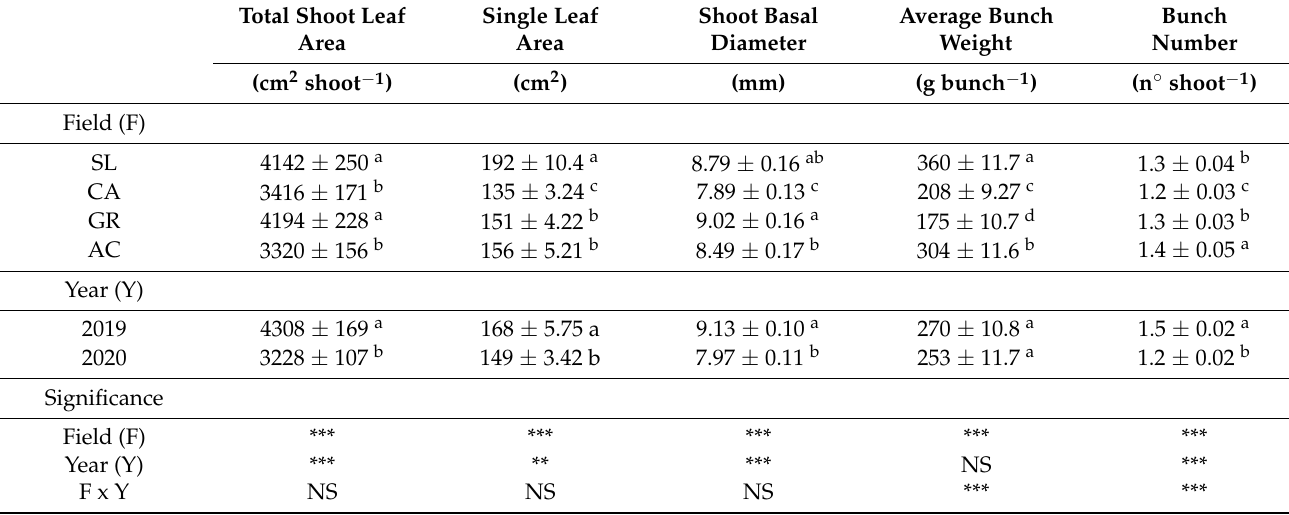
Table 1. Effects of field (F), year (Y), and their interaction (F x Y) on total shoot leaf area, single leaf area, shoot diameter, bunch weight, and bunch number per shoot of V. vinifera subsp. vinifera ‘Falanghina’ vines at the four study sites: SL-Santa Lucia, CA-Calvese, GR-Grottole, AC-Acquafredde. Mean values and standard errors are shown. Total Shoot Leaf Single Leaf Shoot Basal Average Bunch Bunch Area Area Diameter Weight Number (cm 2 shoot − 1 ) (cm 2 ) (mm) (g bunch − 1